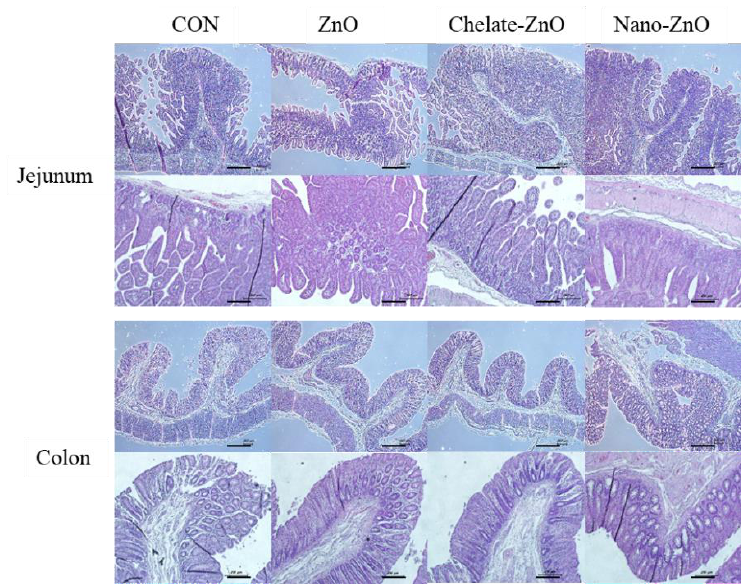
Figure 3. Histological analysis of the intestinal morphology of weaned piglets fed alternative form of zinc oxide. Weaned piglets were given different type of zinc oxide for two weeks. Control piglets were fed without zinc oxide. Figures displays morphology of jejunum and colon tissue from pigs in four dietary treatments. Scale bar = 100 μ M.